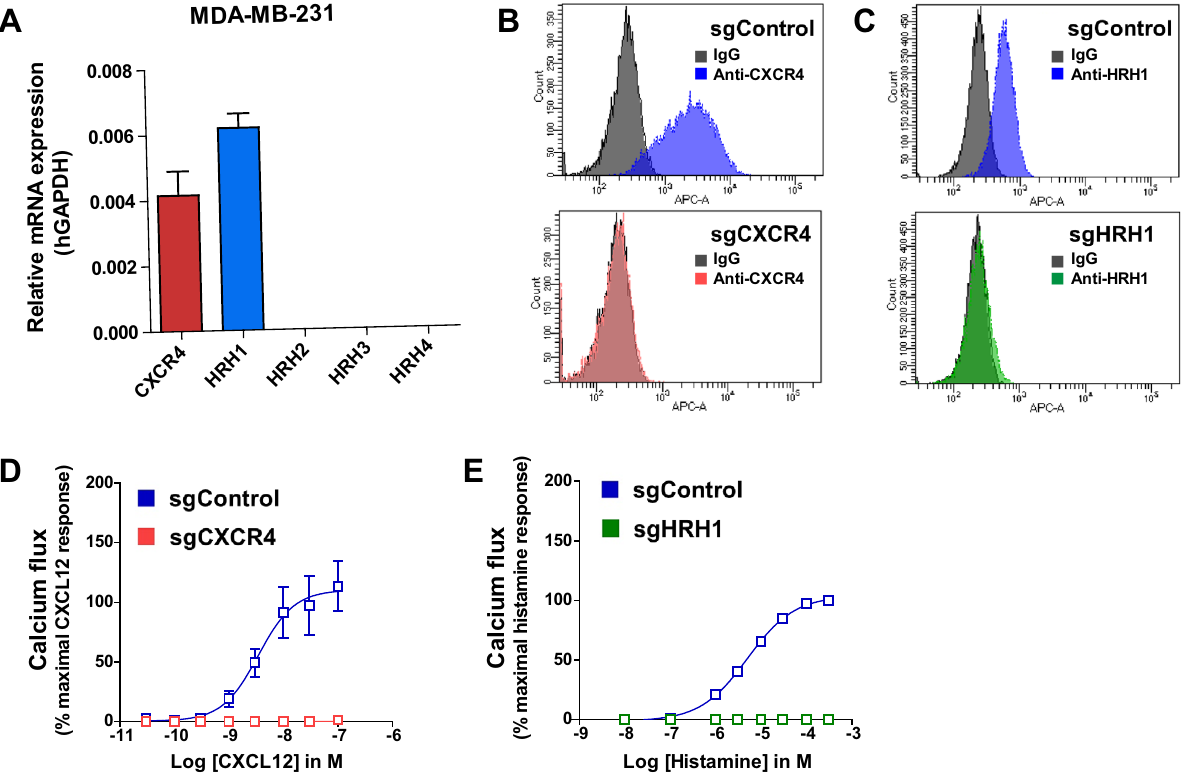
Figure 3. CXCR4 and HRH1 are endogenously coexpressed in MDA-MB-231 breast cancer cells. ( A ) Analysis of the mRNA expression of CXCR4 and histamine receptors in MDA-MB-231 cells using RT ‒ qPCR. Endogenous β-actin was used to normalize the expression of target genes. ( B , C ) Expression of CXCR4 and HRH1 proteins in MDA-MB-231 cells. Cells were transduced with lentiviruses encoding CRISPR/ Cas9 and nontargeting single guide RNA (sgControl), CXCR4-targeting single guide RNA (sgCXCR4), or HRH1-targeting single guide RNA (sgHRH1). After puromycin selection, cells were stained with an anti- CXCR4 antibody ( B ) or an anti-HRH1 antibody ( C ). ( D , E ) Functional expression of CXCR4 and HRH1 in MDA-MB-231 cells. Cells were stimulated with increasing doses of CXCL12 ( D ) or histamine ( E ), and calcium flux was measured. Data are expressed as mean ± s.e.m. (n =